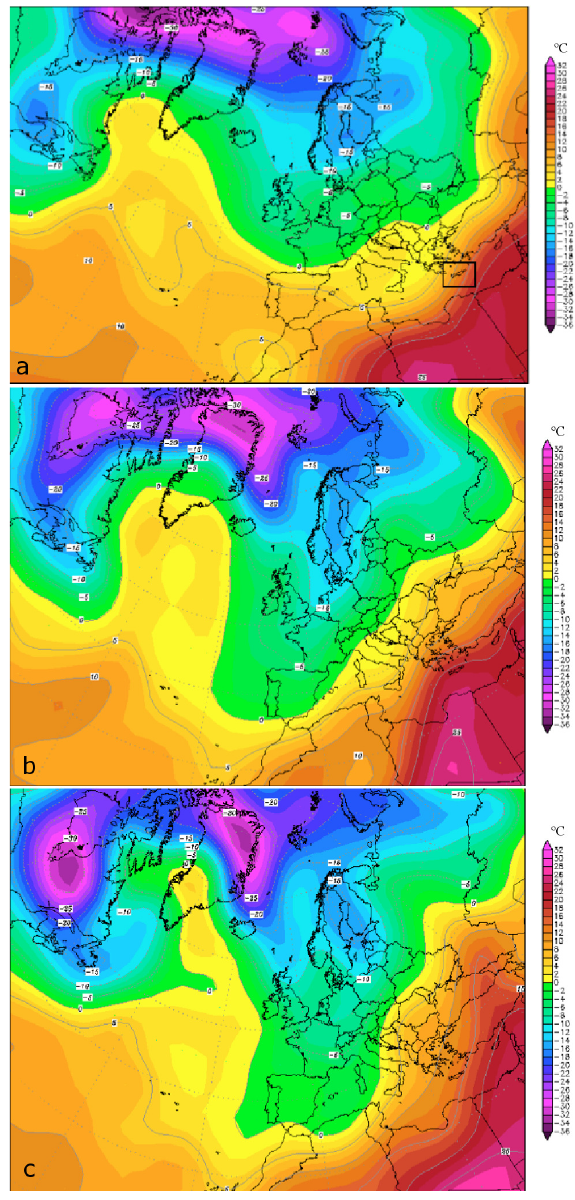
Fig. 5. Temperature at 850 hPa obtained by the NCEP reanalysis at 00:00 UTC on (a) 22, (b) 23 and (c) 24 March 2008. The black square in (a) is centered over Crete.